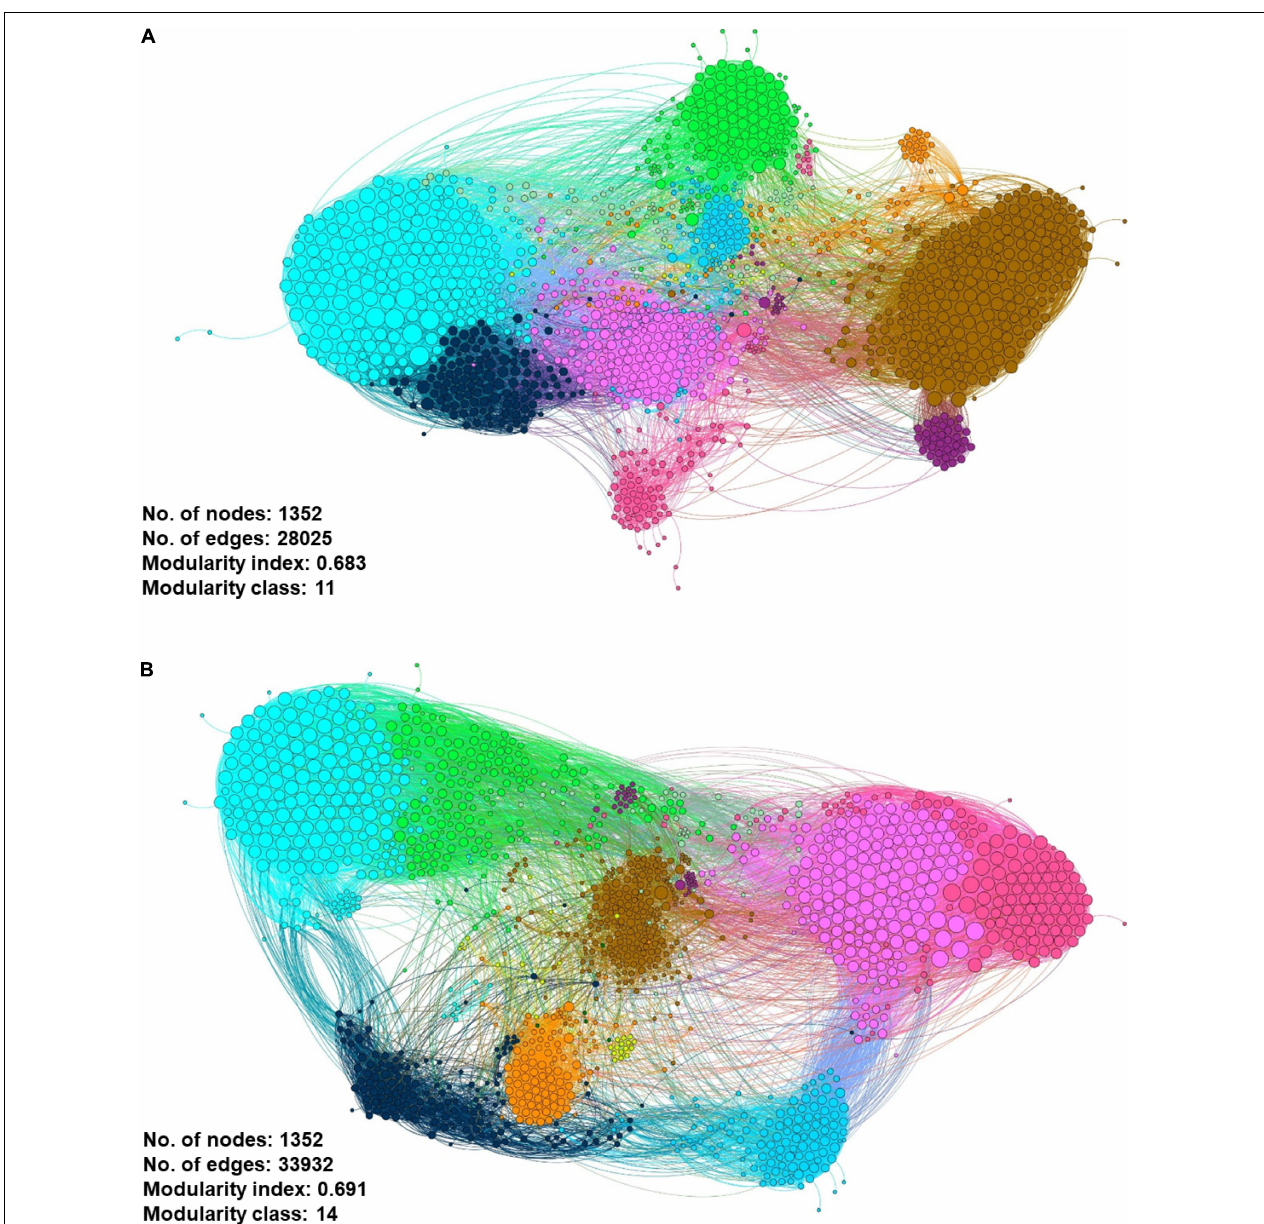
FIGURE 11 | Co-occurrence meta-network analysis showing the correlation between ARG–ARG, ARG–species, and species–species analyzed in (A) influent-only and (B) effluent-only water environments. Only connections with positive strong Spearman’s ρ rho-value > 0.8 and statistically significant p -value FDR-adjusted < 0.01 were displayed in the network. In addition, in the networks, the size of the nodes is proportioned to eigenvector degree, while the width of lines between nodes is proportioned to the correlation coefficient of Spearman’s ρ rho-value. The nodes are colored according to the calculated modularity classes, and they represent either an ARG or species